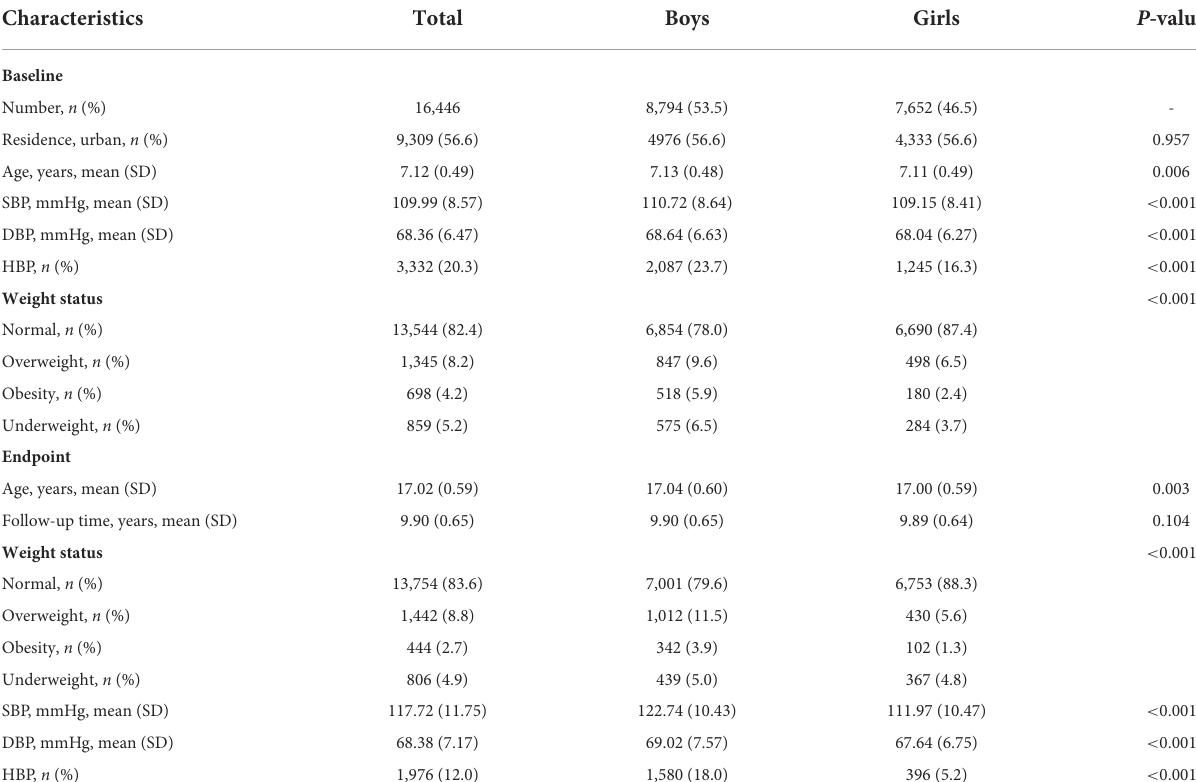
TABLE 1 Descriptive statistics of participants at baseline and at